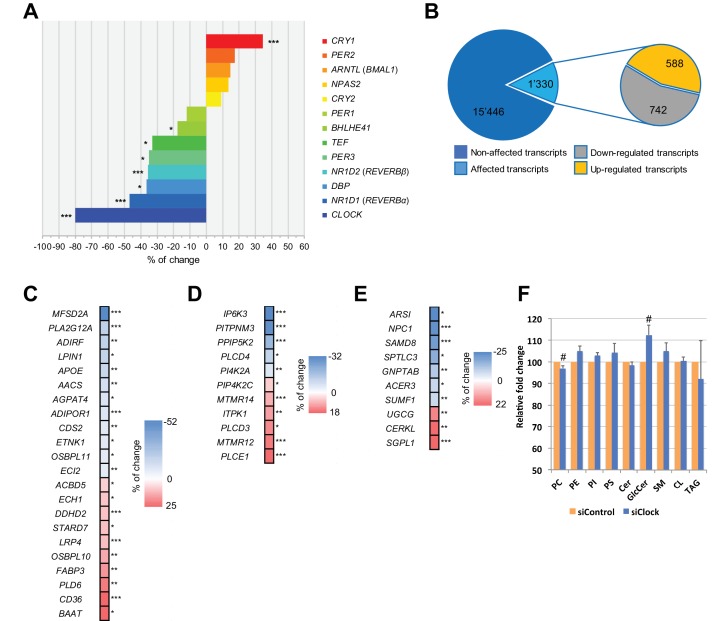
Disruption of the circadian oscillator impacts on functional gene expression hSKM.Differential gene expression analysis between hSKM bearing a disrupted (siCLOCK) or intact (siControl) circadian clock. Comparison of the median gene expression at all analyzed circadian time points between the two groups. A total of 16,776 genes were detected by RNA-seq as expressed above the threshold of counts per million (CPM) >3. (A) Core clock genes; (B) 15,446 genes remained unchanged (dark blue), and 1330 genes exhibited a significantly different expression level upon siCLOCK-mediated clock disruption (light blue), with 588 being up-regulated (orange) and 742 down-regulated (grey) (FDR <0.05 and p-value <0.05). Altered genes comprised those related to glycerophospholipid and triglyceride metabolism, storage and transport (C) inositol phosphate metabolism (D) and sphingolipid metabolism and storage (E). (F) Relative levels of PC, PE, PI, PS, Cer GlcCer, SM, CL and TAG, analyzed by mass spectrometry based lipidomics in hSKM cells transfected with either siControl (orange bar) or siCLOCK (blue bar). Total phosphatidylcholine (PC) and glycosylceramide (GlcCer) levels are significantly decreased or increased, respectively, upon siCLOCK transfection. Data are mean ± SEM, N = 4 (# p-value <0.05). (*) for FDR <0.05, (**) for FDR <0.01, (***) for FDR <0.001.10.7554/eLife.34114.009Figure 2—source data 1.List of 16,776 genes identified in hSKM by RNA-seq and used for the differential analysis.Related to Supplementary file 1-tables S2-8.10.7554/eLife.34114.010Figure 2—source data 2.GO term enrichment analysis, using the Panther classification system, for transcripts that were down- and/or upregulated upon clock disruption.Related to Supplementary file 1-table S4.10.7554/eLife.34114.011Figure 2—source data 3.Reactome pathway analysis, using the Panther classification system for transcripts that were down- and/or upregulated upon clock disruption.Related to Supplementary file 1-table S5.